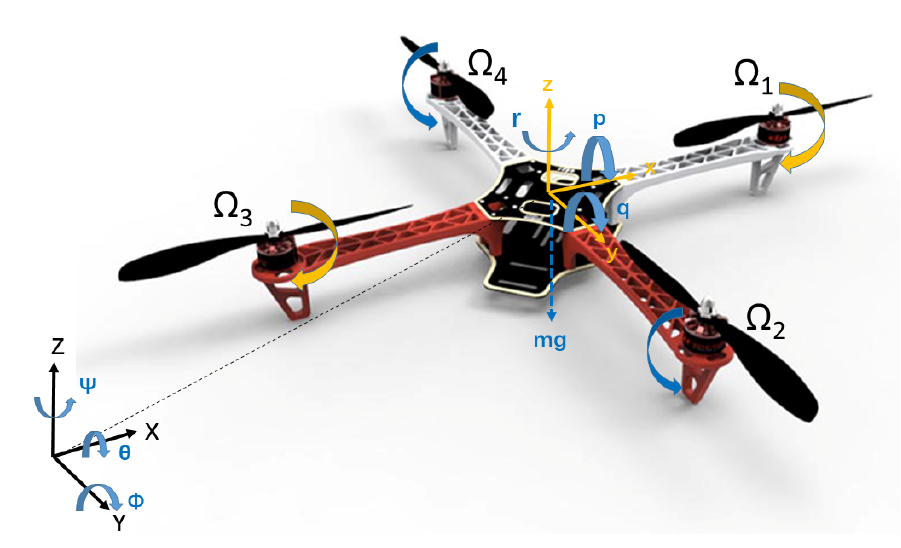
Figure 1. A cross-type quadrotor